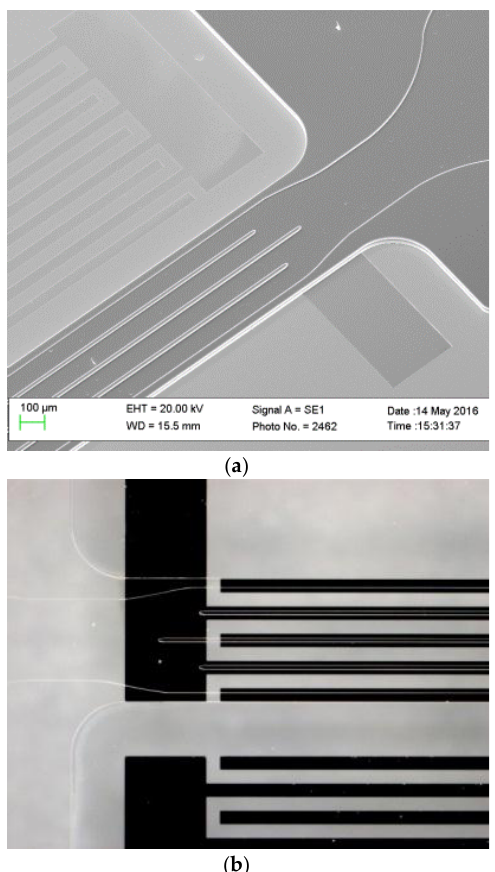
Figure 2. ( a ) SEM images of the fabricated microfluidic structures atop the interfacial layer; ( b ) microscope image of the completed SAW-based phononic microfluidic structure.